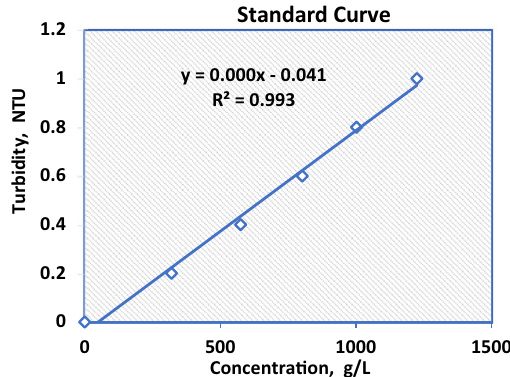
Figure 2. Oil standard calibration curve.